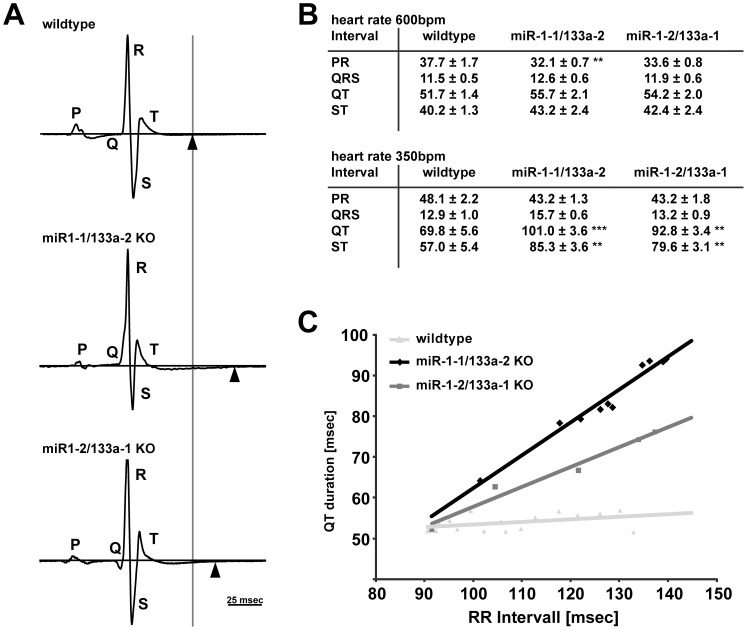
Loss of miR-1/133a impairs cardiac repolarization.Analysis of surface ECGs from immobilized animals revealed an increased QT duration (A). The increased QT duration was obvious especially at low heart rates (longer RR interval) induced by anesthesia with Isoflurane (B). We did not observe changes in PR or QRS interval length, nor arrhythmia or changes in the morphology of the ECG traces. The increased QT interval length is based on a longer ST duration. As shown in (C) the slope of a linear fit (ΔQT/ΔRR) is greater in miR-1/133a single cluster compared to the WT animals.